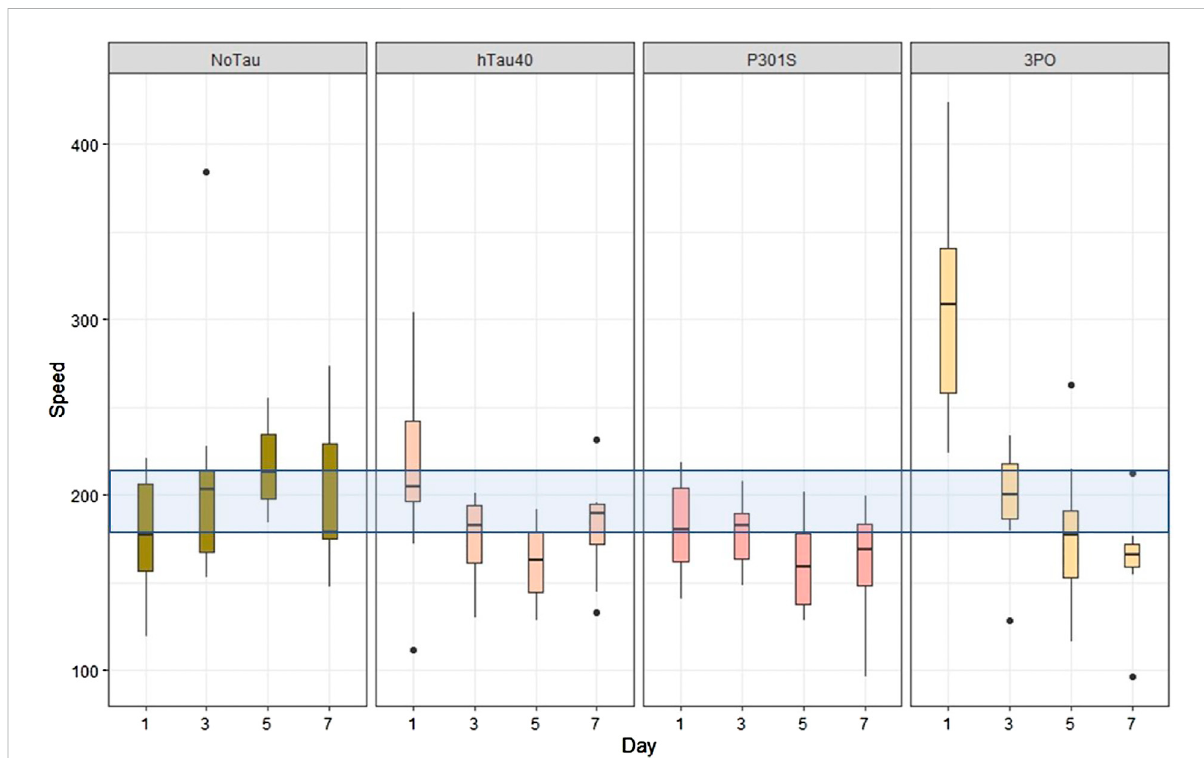
FIGURE 6 Expression of mutant tau affects locomotion. Animal motility was acquired by video microscopy and analyzed using tracking software (WormLab). When the speed of movement was quanti fi ed, the 3PO animals exhibited a hyperactive behavior on day one, but movement progressivelyslowedastheanimalsaged.Movementspeedisplottedbyday,withthebluetransparentbarindicatingtherangeofthemeanspeedof the control animals ( evIs111 ) from all the days measured. The day one 3PO animals were signi fi cantly different from all the other lines on each day ( p < 0.001). N = 10 for each transgene on each